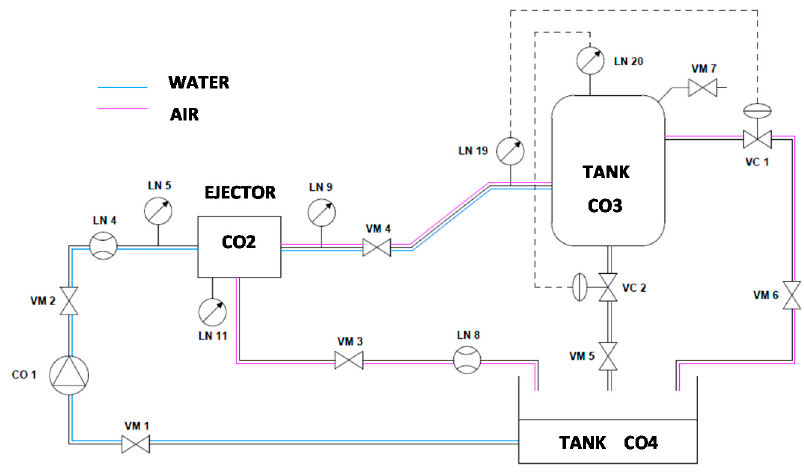
Figure 3. Plant functional scheme.